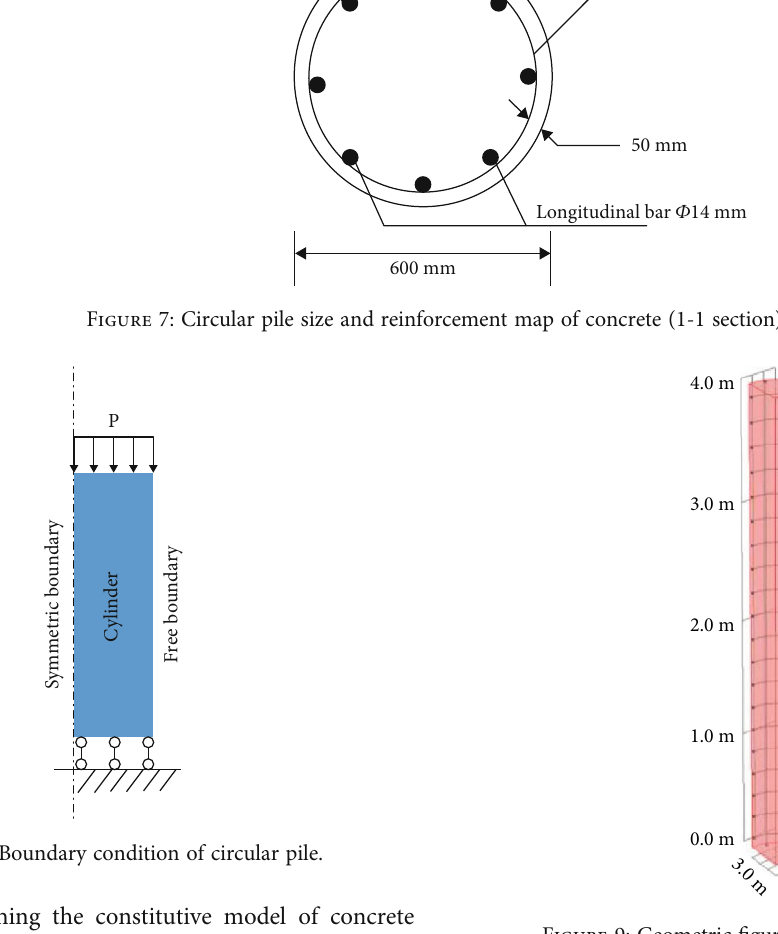
Figure 9: Geometric fi gure of numerical model. Table 8: Parameters for numerical